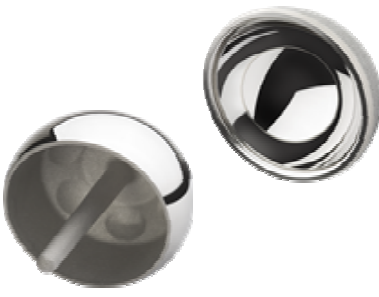
Fig. 3 A typical metal-on-metal hip resurfacing prosthesis (ASR® from DePuy International Ltd, Leeds,